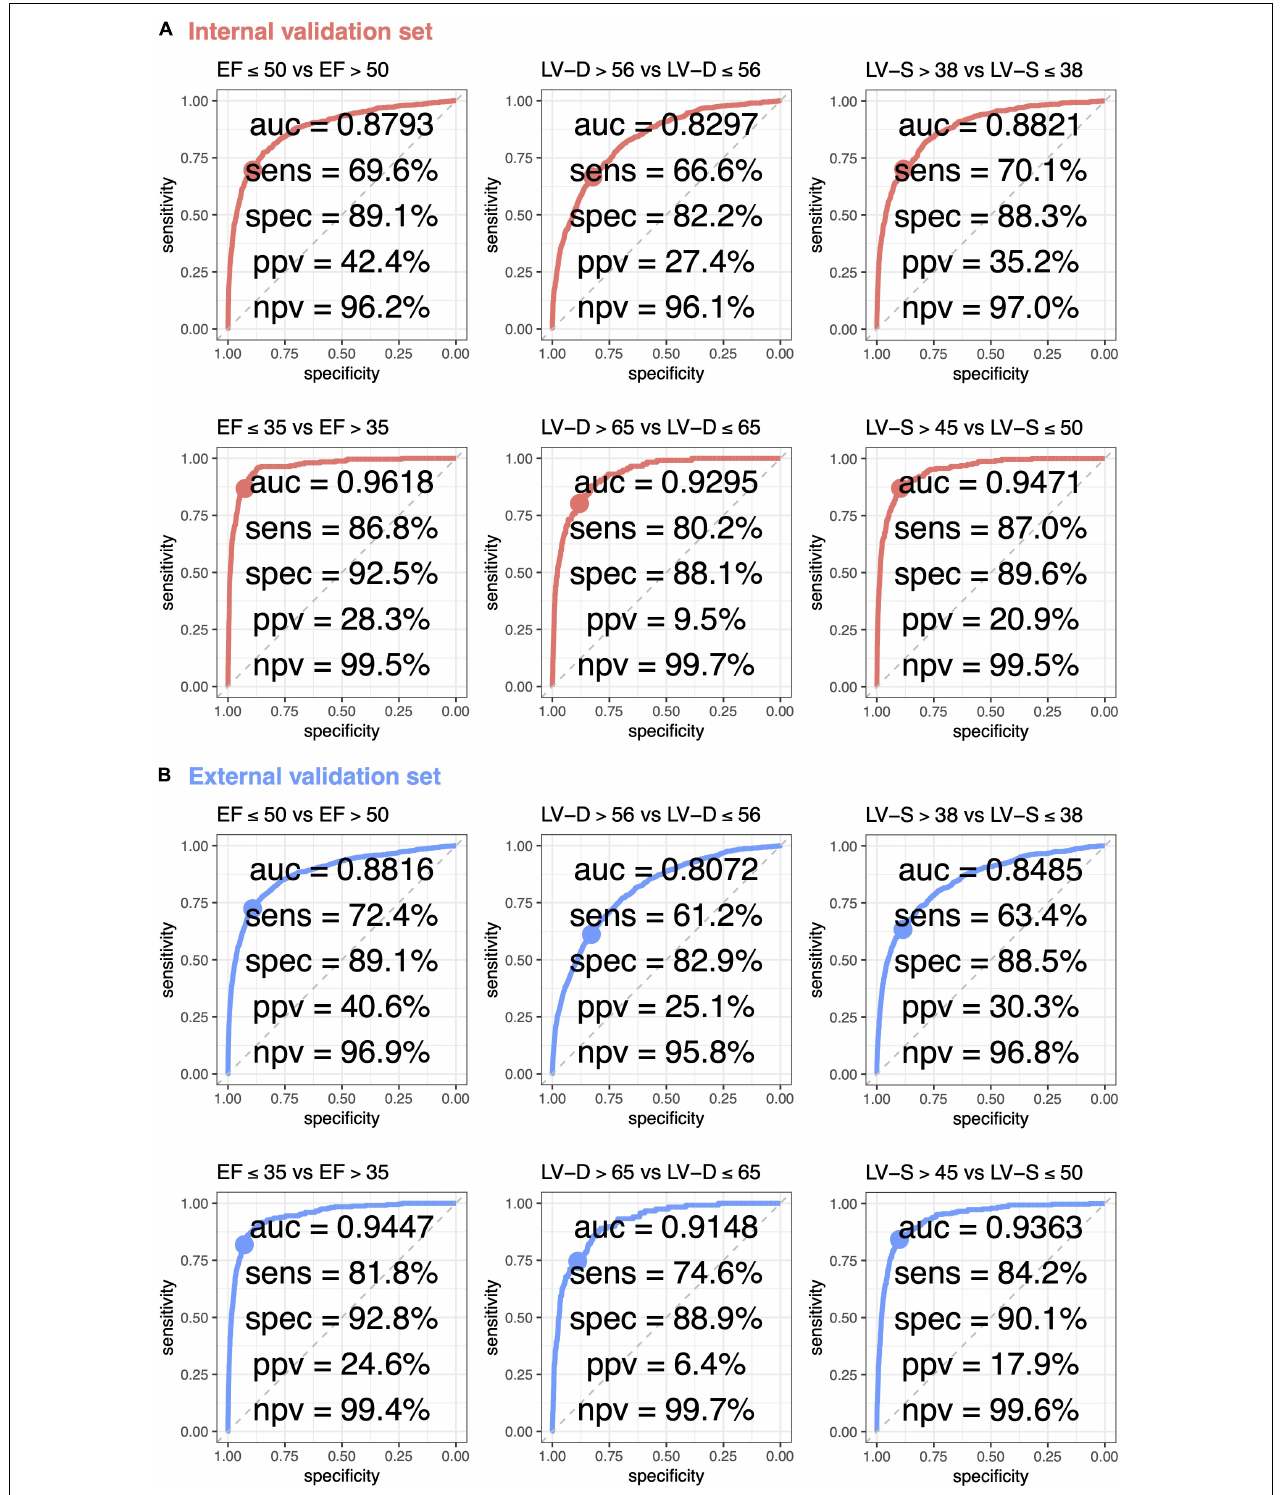
FIGURE 3 | Receiver operating characteristic (ROC) curve analysis for mild to severe left ventricle abnormality from deep learning model based ECG voltage–time traces. The ROC curve ( x -axis = specificity and y -axis = sensitivity) and area under ROC curve (AUC) were calculated using the internal validation set (A) and external validation set (B) . The operating point was selected based on the maximum of Yunden’s index in tuning set, which was used for calculating the corresponding sensitivities and specificities in two validation sets.